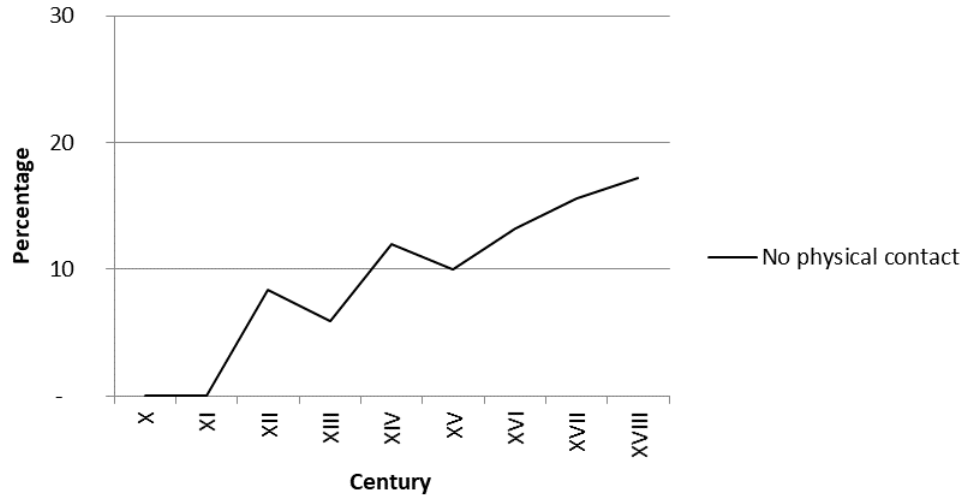
Figure 11. Mother and child separate (Spain, tenth to eighteenth centuries). Source: Authors’ elaboration Figure 11. Moth er and child separate (Spain, tenth to eighteenth centuries). Source: Authors’ based on Trens elaboration based on Trens (1946).